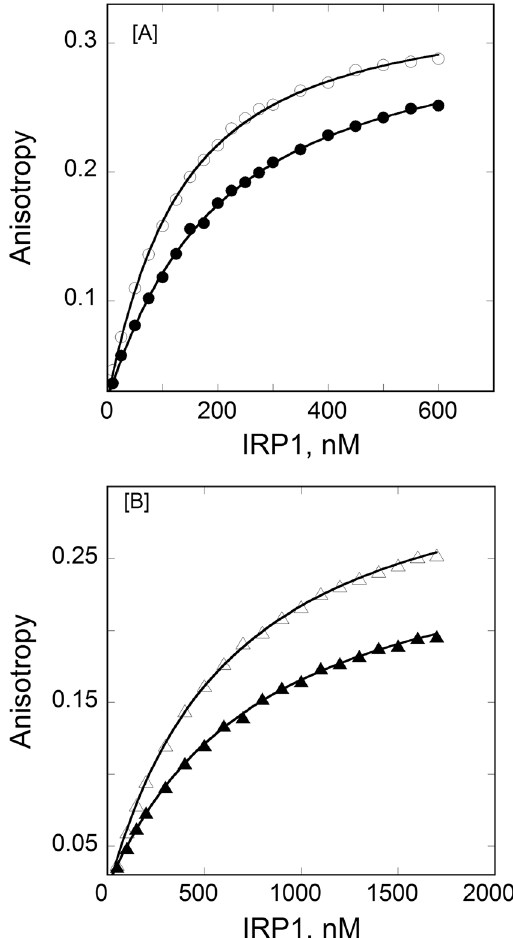
Figure 2. Temperature affects the binding affinity of FRT IRE-RNA with IRP1 repressor protein in presence of metal ions (Mn 2 + ). Panel A , Anisotropy values of FRT IRE-RNA at 10 °C ( ‒○‒ ) and 25 °C ( ‒⦁‒ ) with IRP1 protein plus Mn 2 + . Panel B , the anisotropy values of ACO2 IRE-RNA at 10 °C ( ‒∆‒ ) and 25 °C ( ‒ ▲ ‒ ) with IRP1 protein plus Mn 2 + . The fluorescein tag IRE-RNA concentration was 50 nM and Mn 2 + was 50 µ M in titration buffer. The excitation and emission wavelength were 490 and 520 nm, respectively. The curves were fit to obtain dissociation constant ( K d ) as described in Experimental Procedure. The solid lines are the fitted